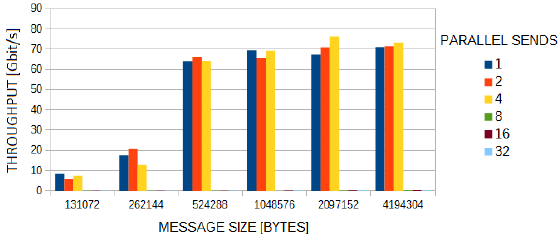
Figure 4. Data producers throughput for Arista switch with DAQPIPE versus the number of used ports.